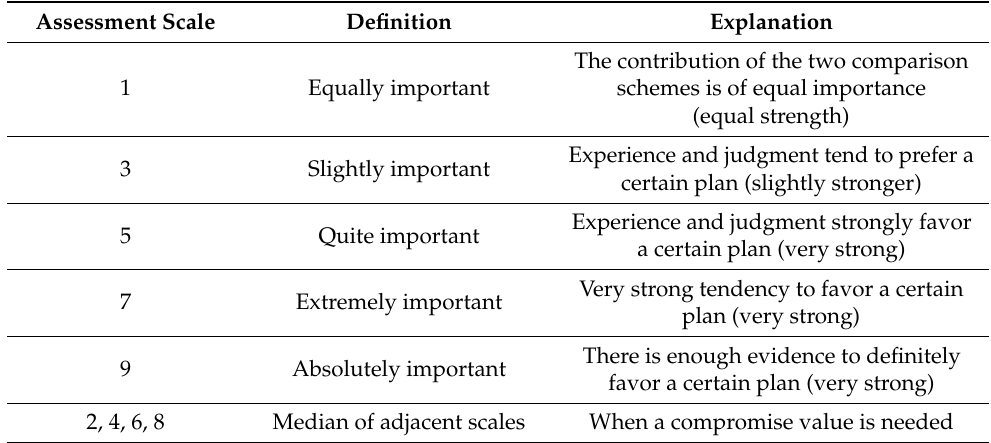
Table 3. AHP evaluation scale meaning and explanation. Assessment